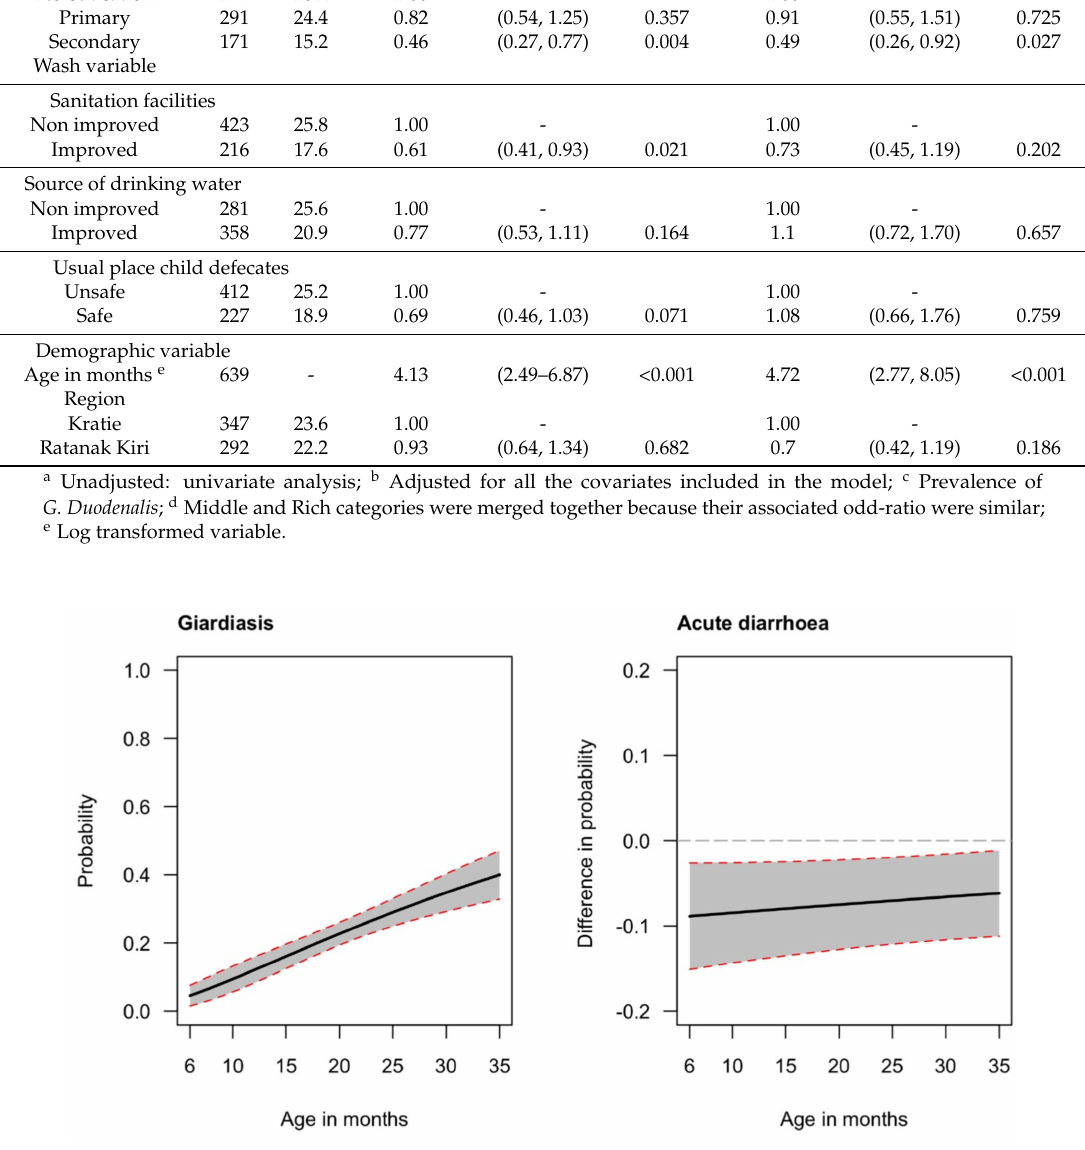
Figure 1. ( Left ): Predicted probability of G. duodenalis infection by age. ( Right ): Average marginal effect of the giardia variable on acute diarrhea. Both, figures were estimated using the multivariate models presented respectively in Tables 2 and 3. Shaded areas represent 95% CI (Confidence